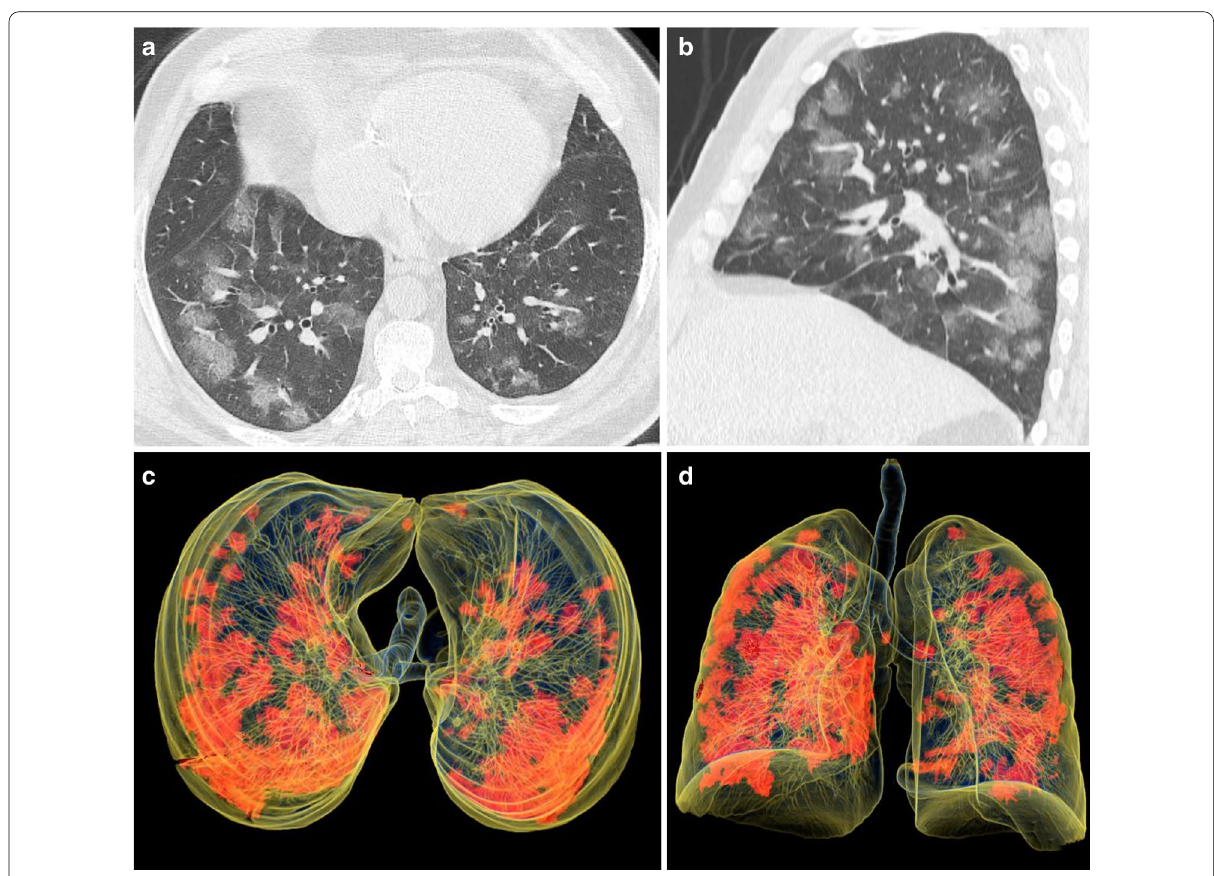
Fig. 1 Typical CT imaging features for COVID‑19. a , b A 54‑year‑old man with positive RT‑PCR test, axial and sagittal reformatted CT images shows multifocal rounded GGO with predominant peripheral distribution. c , d Three‑dimensional semitransparent volume‑rendered reconstructions show the peripheral and basal distribution of the ground‑glass opacities across both lungs